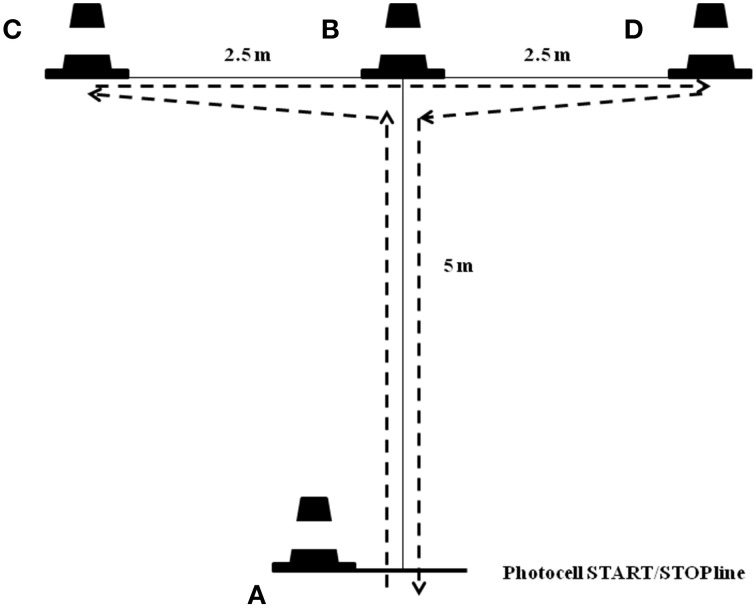
Schematic representations for Modified Agility Test (MAT).